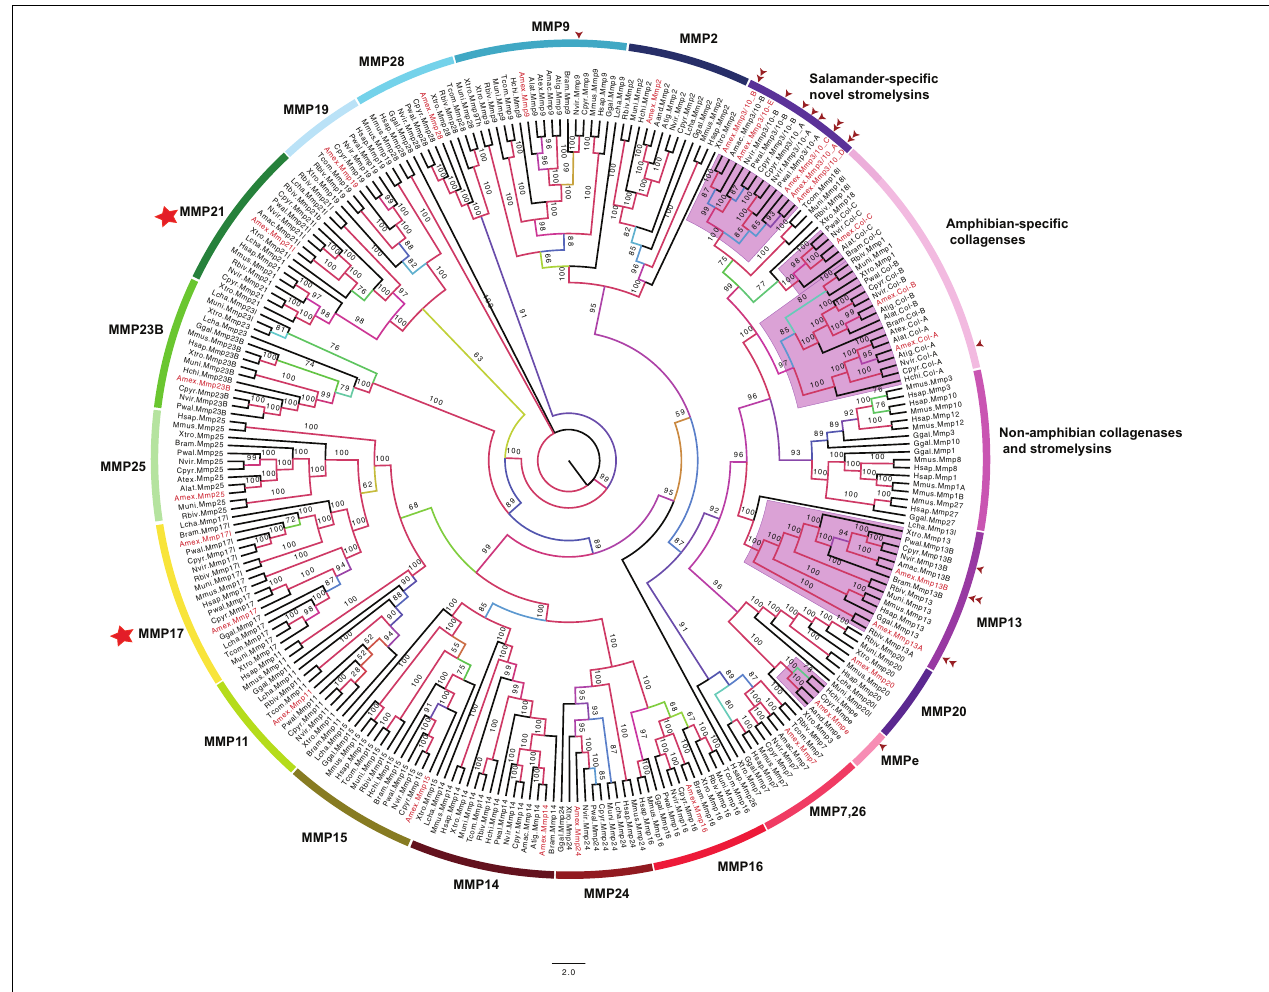
FIGURE 2 | Unrooted maximum likelihood phylogenetic tree of tetrapod MMPs. Numbers on tree branches are bootstrap values and clades are labeled to show MMP gene types, which were determined by orthology. All axolotl MMPs are colored in red. Purple-highlighted clades indicate salamander-specific MMP expansions. The abbreviation for species used in transcript identifiers are: Ambystoma mexiacunm (Amex), Ambystoma tigrinum (Atig), Ambystoma laterale (Alat), Ambystoma andersoni (Aand), Ambystoma maculatum (Amac), Ambystoma texanum (Atex), Cynops pyrrhogaster (Cpyr), Bolitoglossa ramosi (Bram), Notophthalmus viridescens (Nvir), Pleurodeles waltl (Pwal), Hynobius chinensis (Hchi), Rhinatrema bivittatum (Rbiv), Microcaecilia unicolor (Mun), Typhlonectes compressicauda (Tco), Xenpous tropicalis (Xtr), Gallus gallus (Ggal), Mus musculus (Mmus), Homo sapiens (Hsap), and Latimeria chalumnae (Lcha). One arrow head: Transcript sequenced previously, two arrow heads: Gene sequenced from axolotl BAC resources. Stars indicative of amphibian-specific expansion in MMP17 and 21 clades.